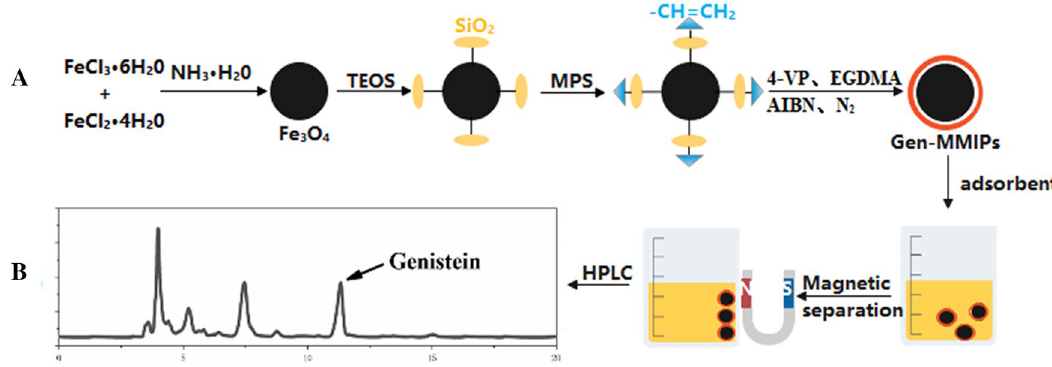
Figure 1. Synthesis and detection of